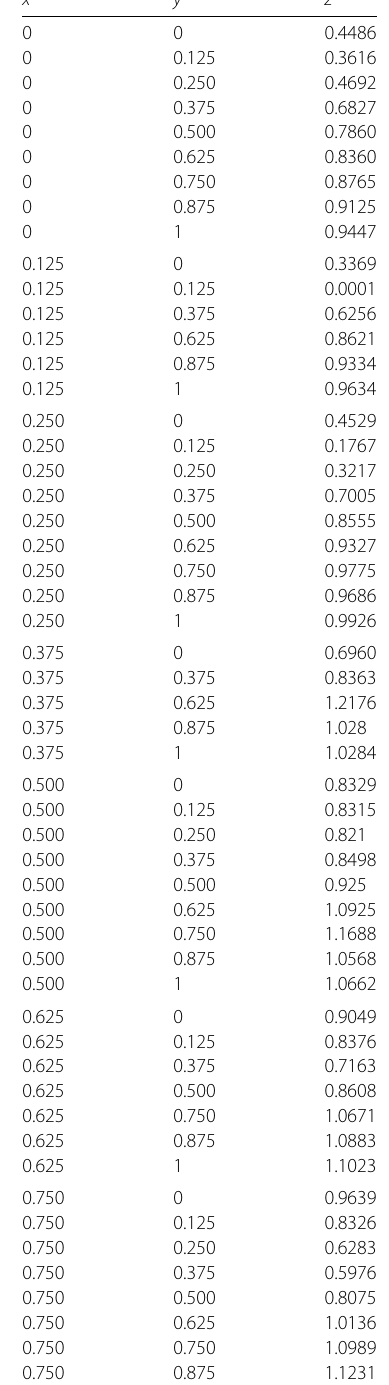
Table 5 Irregular data from Ibraheem et al.